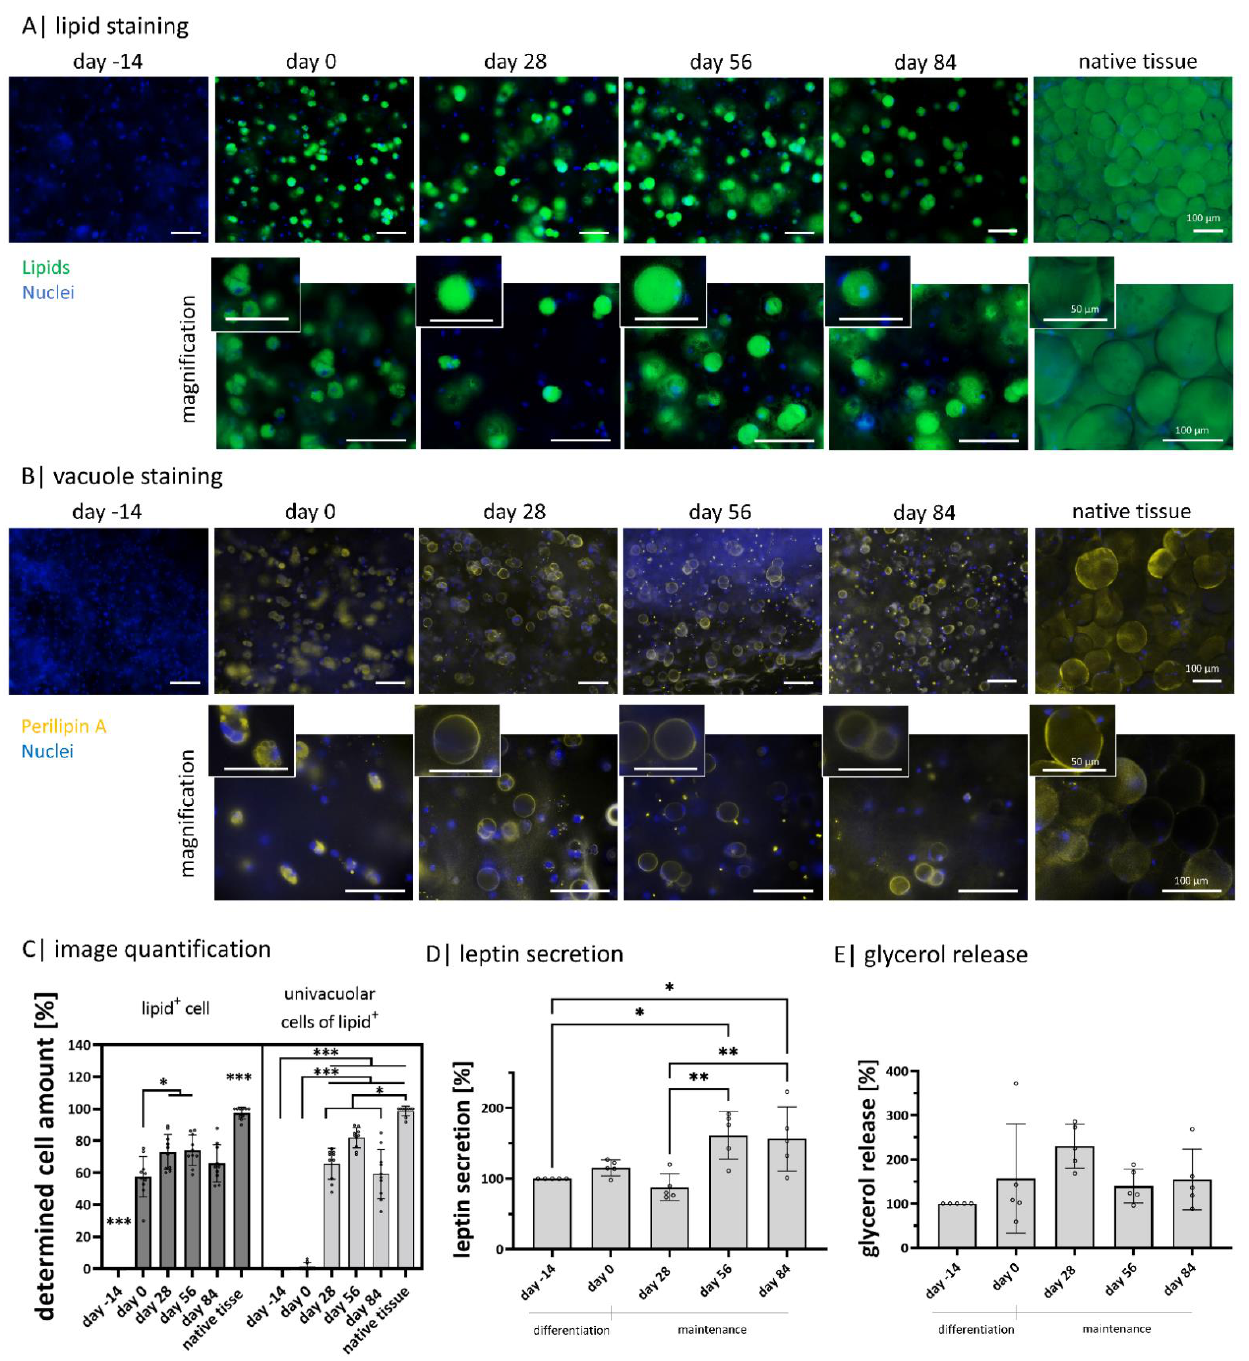
Figure 3. Intracellular lipids and adipokine secretion within Gellan gum hydrogels: ( A ) visualization of intracellular lipids of encapsulated diffASCs for 98 days and explanted lobuli after 24 h. Stained with BODIPY, lipids in green, nuclei in blue. Scale bar 100 µM, n = 5; ( B ) visualization of perilipin A as an intact lipid vacuole membrane protein in encapsulated diffASCs for 98 days and explanted lobuli after 24 h. Stained with anti-perilipin A antibody in yellow, nuclei in blue. Scale bar 100 µM, n = 5; ( C ) determined cell number expressing lipids (lipid+) and an univacuolar morphology (percentage of univacuolar cells to lipid+ cells), both increasing with increasing culture time; ( D ) normalized adipokine secretion (leptin) of diffASCs in GG-hydrogels for 98 days, n = 5; ( E ) normalized glycerol release of encapsulated diffASCs in GG-hydrogels for 98 days, n = 5. ◦ sample values, * p ≤ 0.05; ** p ≤ 0.01; *** p ≤ 0.001